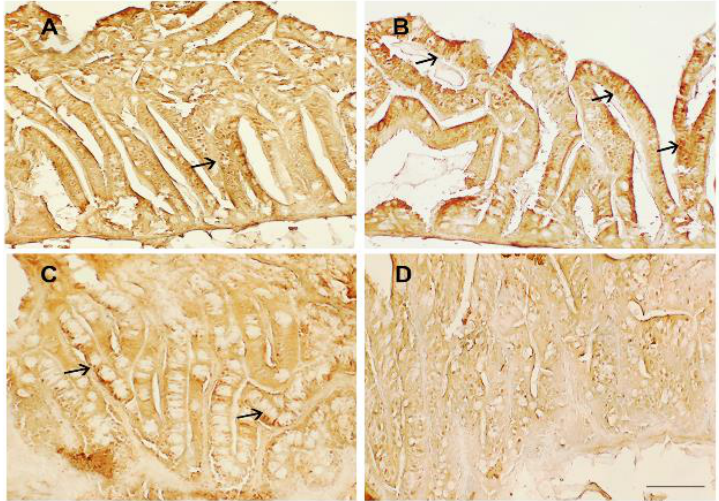
Figure 3. COX2 immunostaining in the intestines of ( A ) zebrafish fed the control diet; ( B ) TSP I, zebrafish fed the control diet supplemented with TSP at 0.9 g/kg of feed; ( C ) TSP II, zebrafish fed the control diet supplemented with TSP at 1.7 g/kg of feed; and ( D ) TSP III, zebrafish fed a diet enriched with TSP at 3.4 g/kg of feed . Scale bar: 100 μm. Arrows indicate COX2 expression on the apical side of epithelial cells.